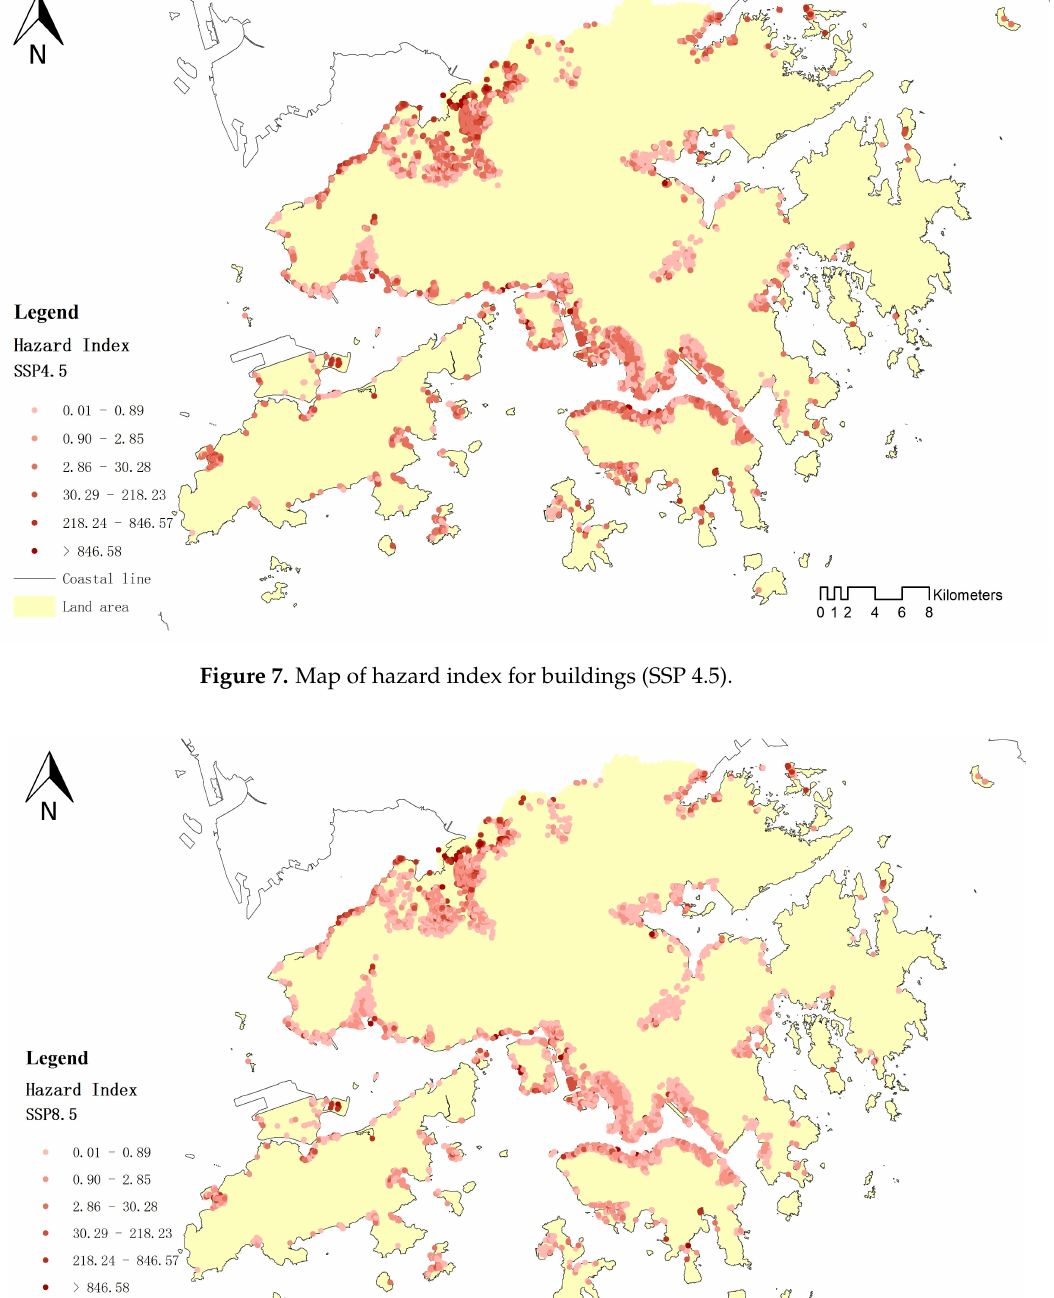
Figure 6. Overlay of building layer and exposure map of SSP 8.5.